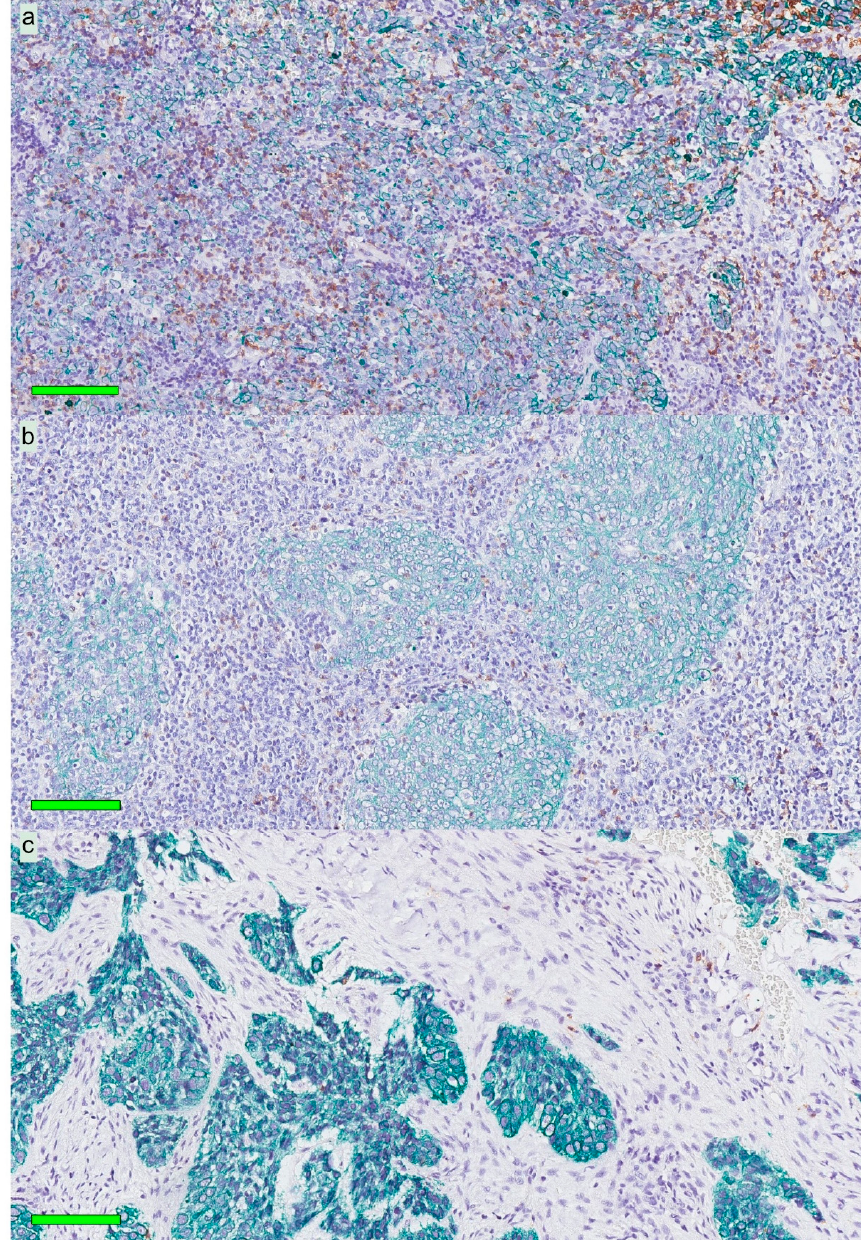
Figure 2. Immune phenotypes for three patients with NPC: Mayer’s hematoxylin in combination with CK (green) and CD8 (brown). All CK expressions denote cancer cells. The top panel ( a ) shows an “inflamed” tumor rich in infiltrating lymphocytes. The middle panel ( b ) indicates an “excluded” tumor with lymphocytes surrounding areas of cancer cells. The bottom panel ( c ) demonstrates a “deserted” tumor with no or very few lymphocytes in areas of cancer cells and the surrounding stroma. Green horizontal bars indicate 100 µ m. Abbreviations: NPC = nasopharyngeal cancer and CK =